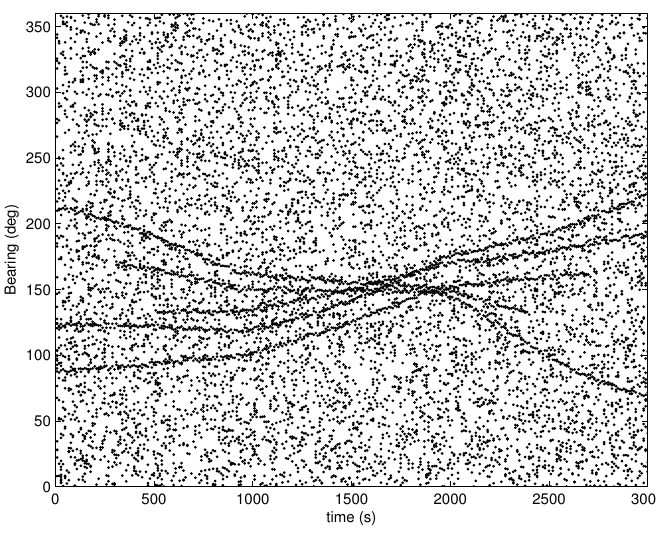
Figure 3. An example of